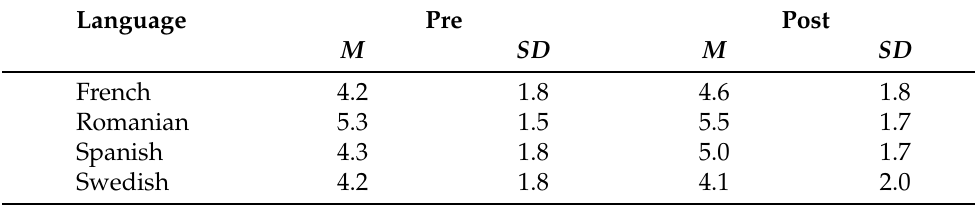
Table A8. I consult fact-checking websites in case of